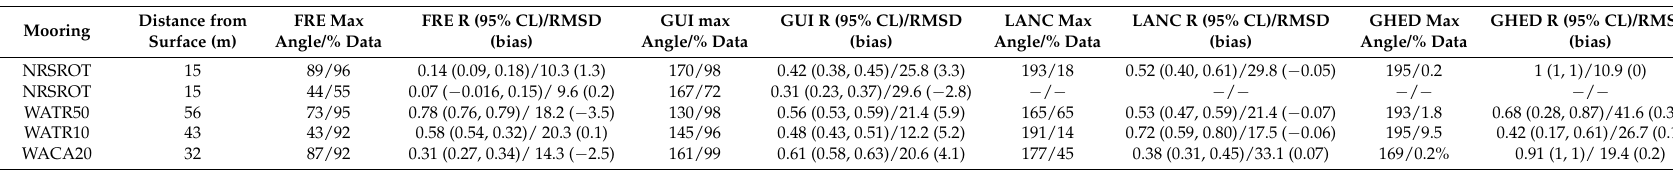
Table 3. Same as Table 1 but for the radar angle at which correlation with mooring currents is maximized. Results are displayed for both WERA and SeaSonde HFR stations. Units for RMSD (bias) are